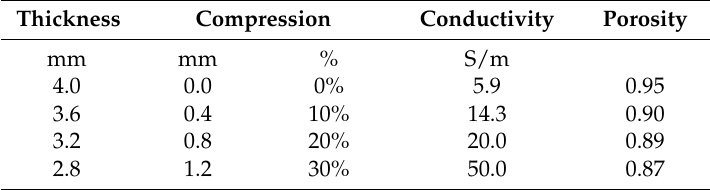
Table 3. Carbon felt electrode data adapted from Park et al. [16].